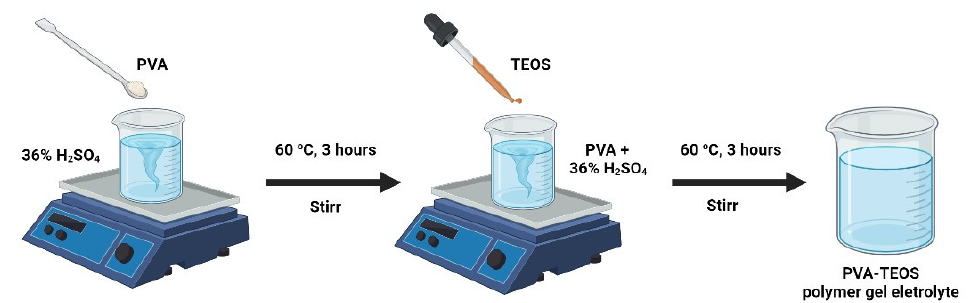
Figure 11. Diagram showing the process for making PVA-TEOS polymer gel electrolyte.